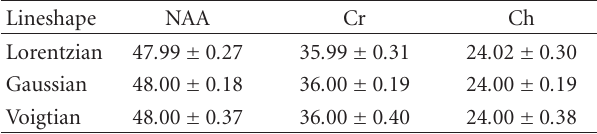
Table 4: Results of Monte Carlo study of the estimated amplitudes (mean ± SD). The true values of NAA, Cr, and Ch are 48, 36, and 24, respectively; the CRLBs are 0.1574, 0.1288, and 0.1858 for Lorentzian, Gaussian, and Voigtian,